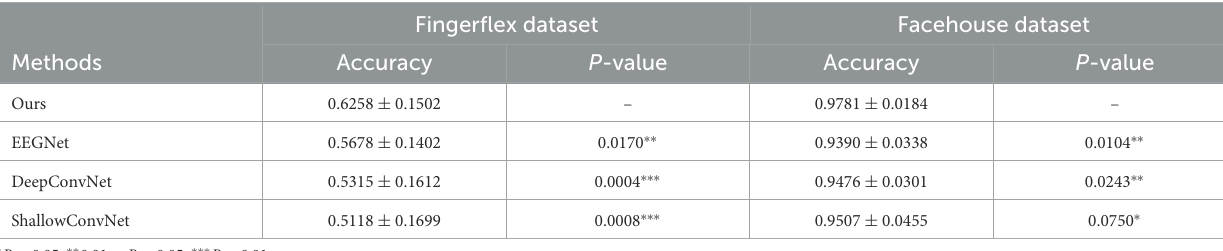
TABLE 1 Overall decoding performance on fingerflex dataset and facehouse dataset.